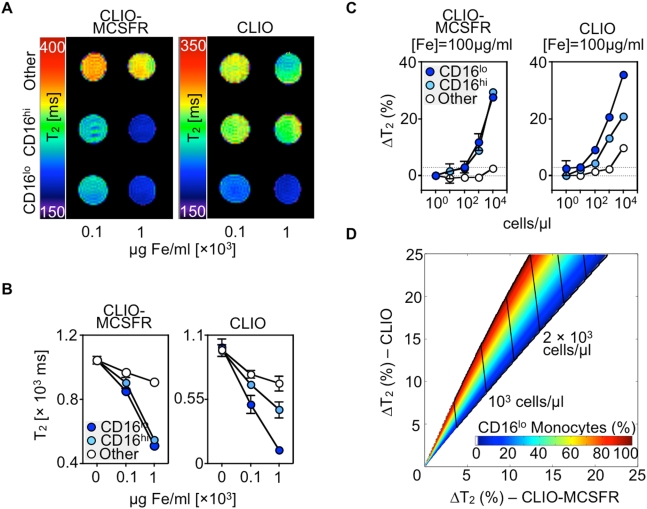
Ex-vivo Nuclear Magnetic Resonance generates an enumerative mathematical model for monocyte subsets.A. Representative NIH-color coded map generated from T2-weighted Magnetic Resonance Imaging. Data show equal number of CD16lo, CD16hi monocytes and other leukocytes labeled with two CLIO-MCSFR (left panel) and CLIO (right panel) concentrations. B. T2 measurements detected with a conventional benchtop-relaxometer. Data show equal number of CD16lo, CD16hi monocytes and other leukocytes labeled with two CLIO-MCSFR (left panel) and CLIO (right panel) concentrations. N = 3–5. Mean±SEM. C. T2 changes detected with a diagnostic magnetic resonance (DMR) chip. Data show increasing number of CD16lo, CD16hi monocytes and other leukocytes labeled with one CLIO-MCSFR (left panel) and CLIO (right panel) concentration. N = 3. Mean±SEM. D. Two-dimensional T2 map derived from data in C to simultaneously enumerate total monocyte numbers and subset proportions. Model combines T2 changes for CLIO-MCSFR (x-axis) and CLIO (y-axis). Changes in predicted monocyte number are demarcated with vertical lines while the rainbow region defines monocyte subset fluctuations.